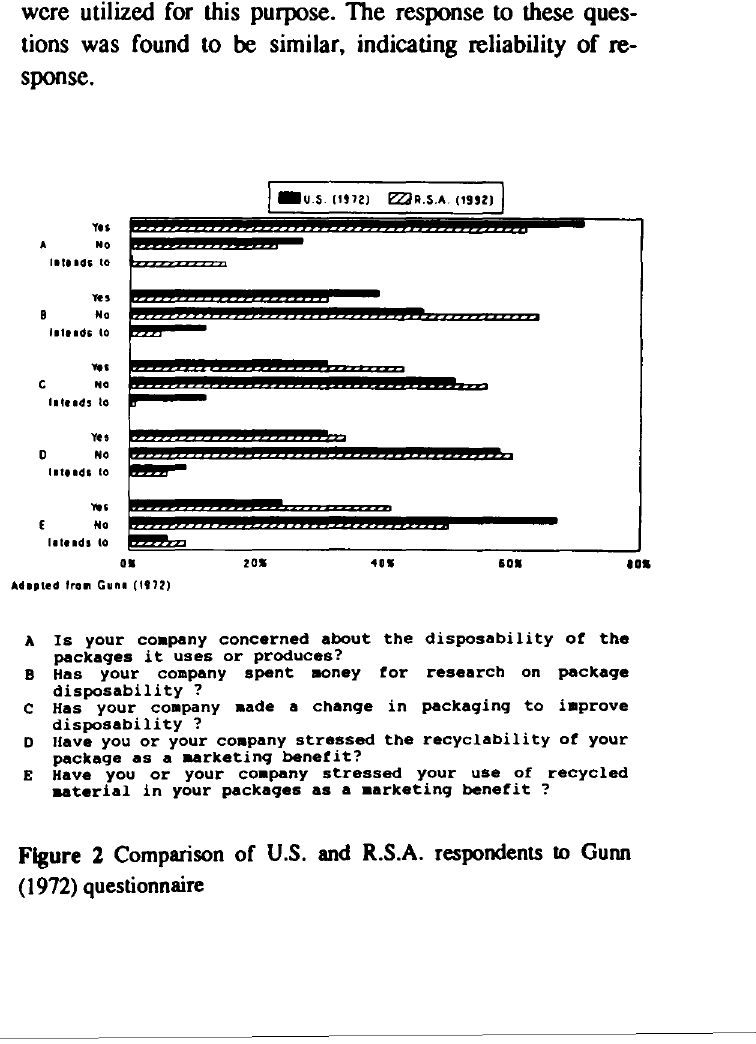
Figure 2 Comparison of U.S. and R.S.A. respondents to